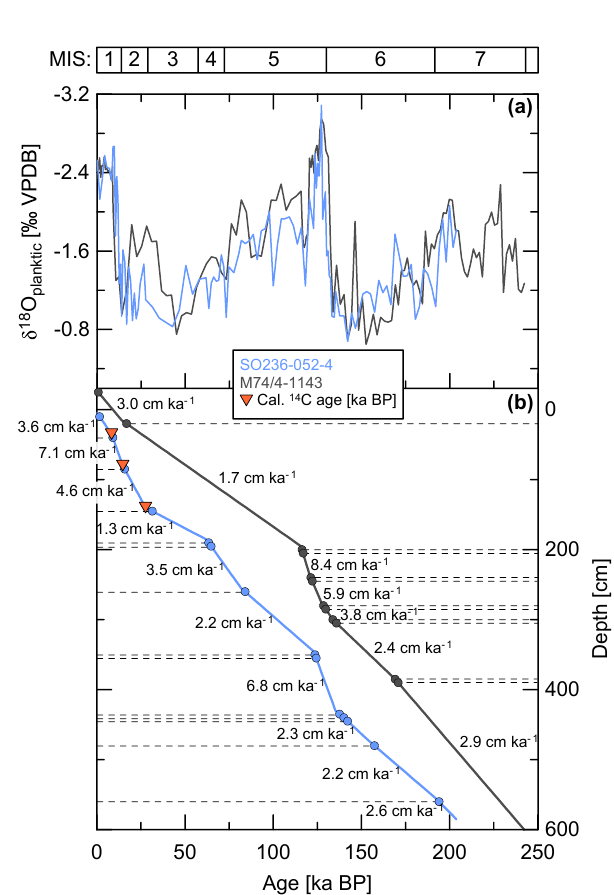
Figure 2. Full-resolution stable oxygen isotope records of the planktonic foraminifer G. ruber (a) and age–depth plots for the sed- iment cores SO236-052-4 (light blue) and M74/4-1143 (grey). Or- ange triangles indicate radiocarbon dates and circles indicate age control points derived from correlation with the LR04 benthic iso- tope stack of Lisiecki and Raymo (2005). Sedimentation rates are derived from linear interpolation between age data. MIS denotes the marine stable oxygen isotope